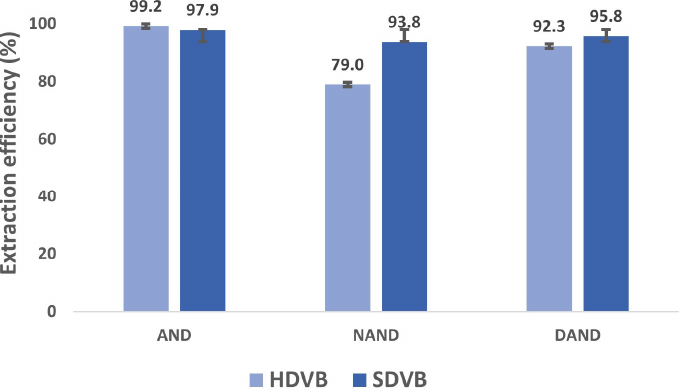
Figure 5. Extraction efficiency (%, n = 3) of andrographolide (AND), neoandographolide (NAND), and 14-deoxy-11,12-didehydroandrographolide (DAND) obtained for polymeric MEPS sorbents (cross-linked polystyrene divinylbenzene copolymer—HDVB and polystyrene-divinylbenzene copolymer—SDVB) expressed as average value ± standard deviation.